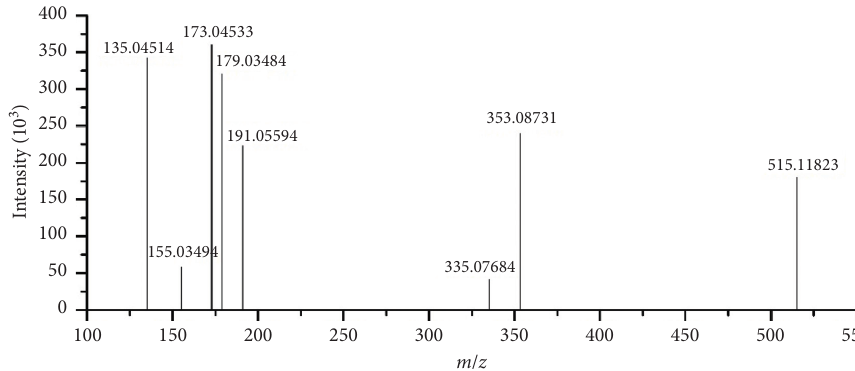
Figure 4: MS 2 spectrum of compound